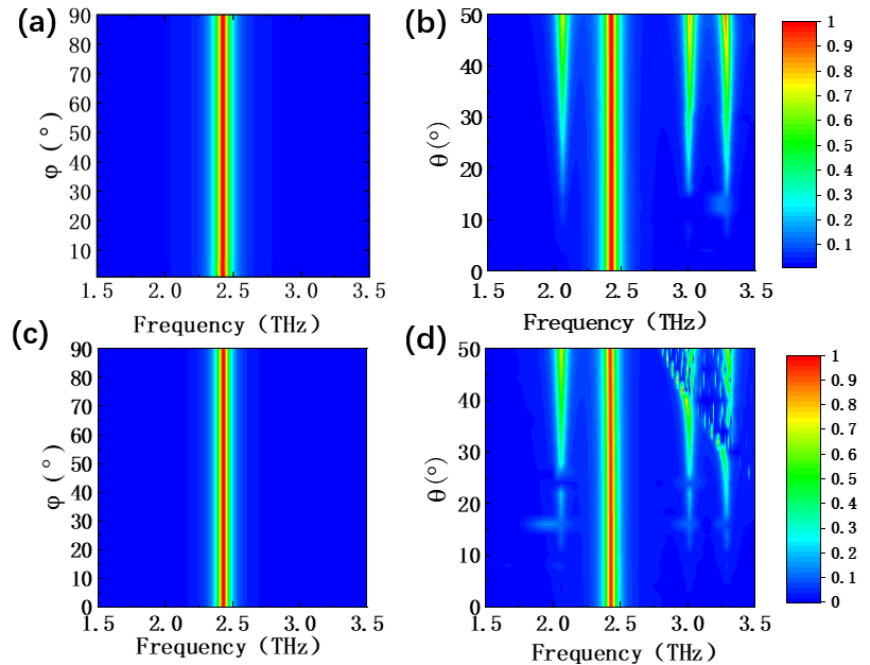
Figure 5. Simulated absorbance spectrum of the proposed PMMA with different ( a ) polarization and ( b ) incident angles in the TM mode and in the TE mode(c)(d) when T =